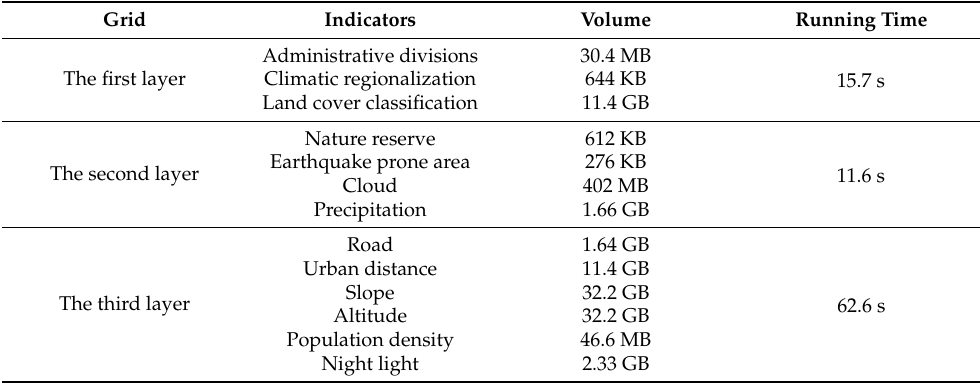
Table 3. Evaluation indicators volume and operation efficiency of DSS-LPV